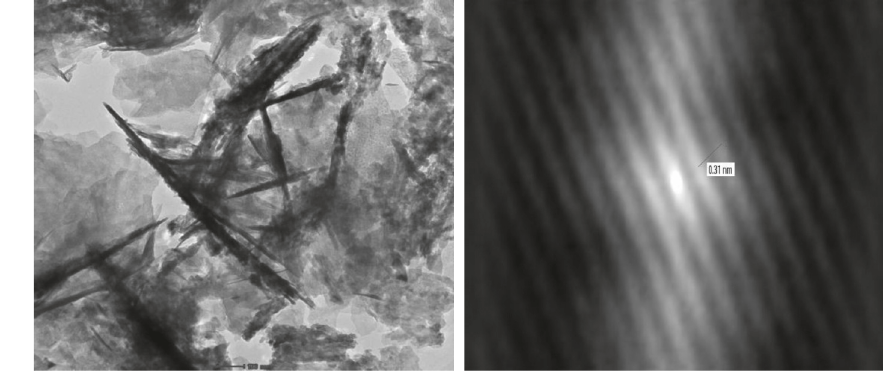
Figure 5: TEM images showing rod-shaped Table 2: Germination rate after 7 and 14 days.